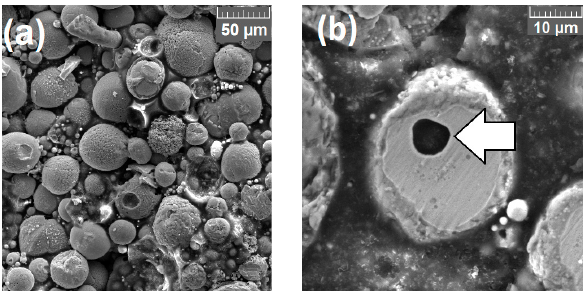
Figure 5. Scanning Electron Microscopy (SEM) of spherical geometry of particles collected in a distance of 200 mm from the gun. ( a ) 410NiMo with magnification of 500 × , and ( b ) 309L with hollow, and oxide formation with magnification of 2500×.